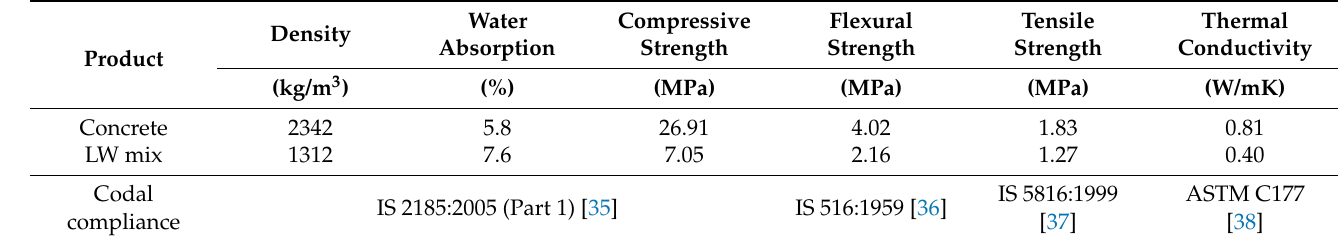
Table 2. Physico-mechanical and functional properties of proposed products.